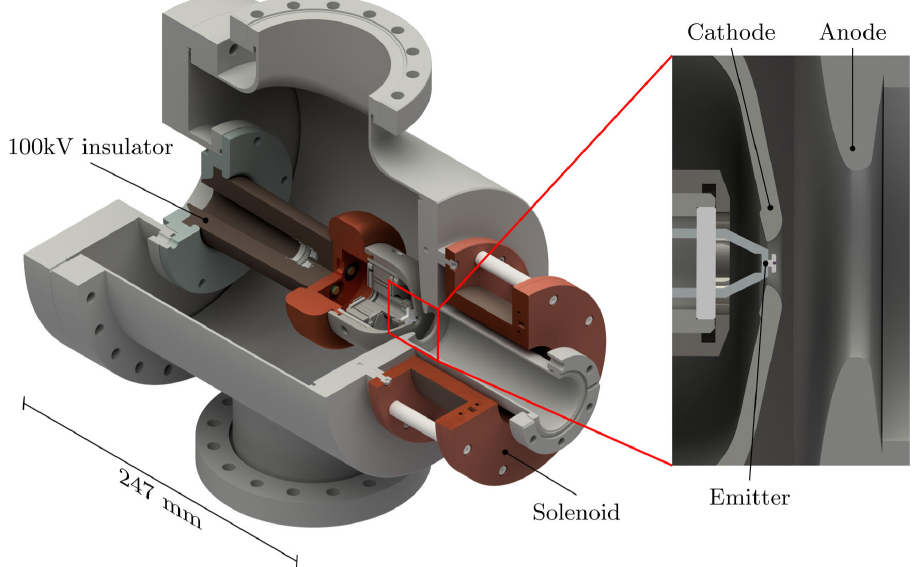
FIG. 2. CAD model of the custom design thermionic gun DC accelerator. The 100 kV insulator is a Claymount R10 HV